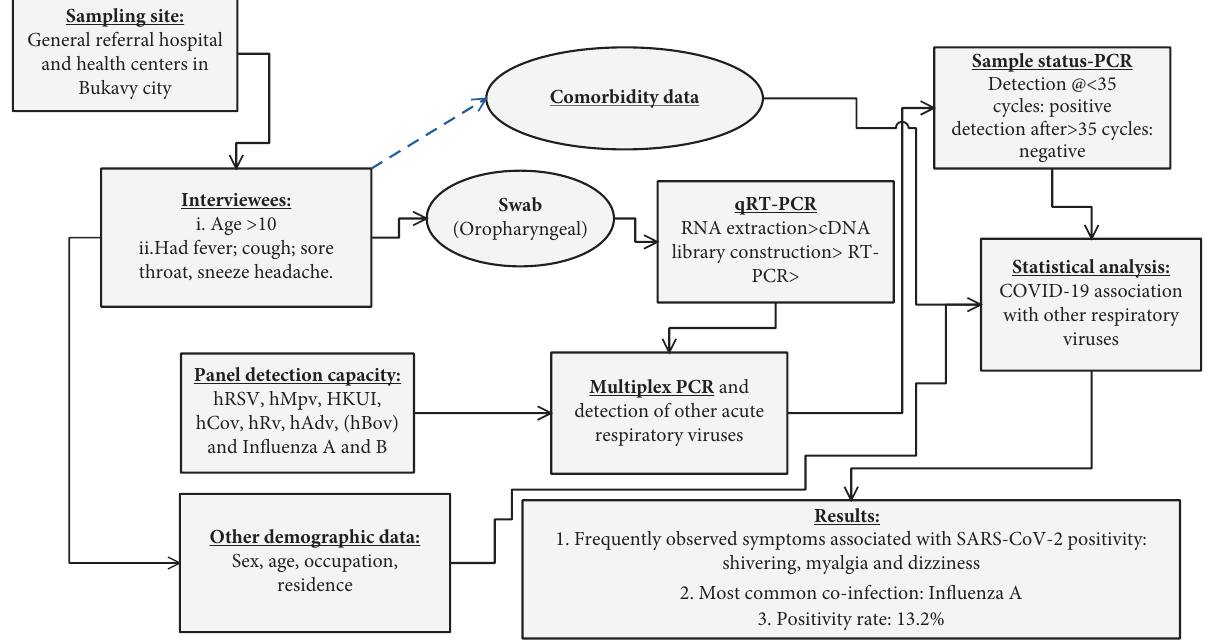
Figure 1: Study design, participants, and results of COVID-19 and other acute respiratory viruses